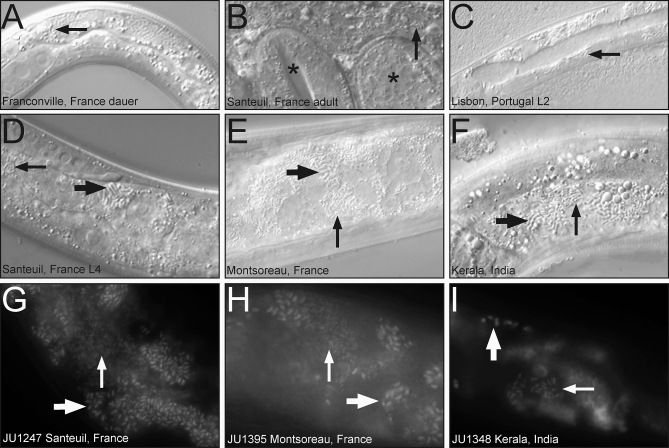
Microsporidia-Infected Caenorhabditis Nematodes Isolated from Diverse Geographical Locations(A) Infected dauer larva isolated in Franconville, France.(B) Infected C. elegans adult isolated in Santeuil, France. This adult was filled with rod-shaped microbes and unable to lay eggs. Progeny inside the adult are indicated with asterisks.(C) Infected L2 larva isolated in Lisbon, Portugal. This individual (like some of the other infected larvae) died before reaching adulthood and producing progeny.(D) Infected L4 larva isolated in Santeuil, France. This animal also died before producing progeny. DIC micrographs taken within 24 h after sampling for (A–D).(E) Infected F1 progeny of C. elegans isolated in Montsoreau, France.(F) Infected progeny of C. briggsae from India.(G–I) RNA FISH staining with MicroA, a probe for N. parisii rRNA.(G) JU1247, an infected C. elegans strain isolated in Santeuil, France.(H) JU1395, an infected C. elegans strain isolated in Montsoreau, France.(I) JU1348, an infected C. briggsae strain isolated in Kerala, India.(A–I) Smaller arrow indicates smaller rod-shaped microbes, larger arrow indicates larger rod-shaped microbes, both of which are microsporidian spores.